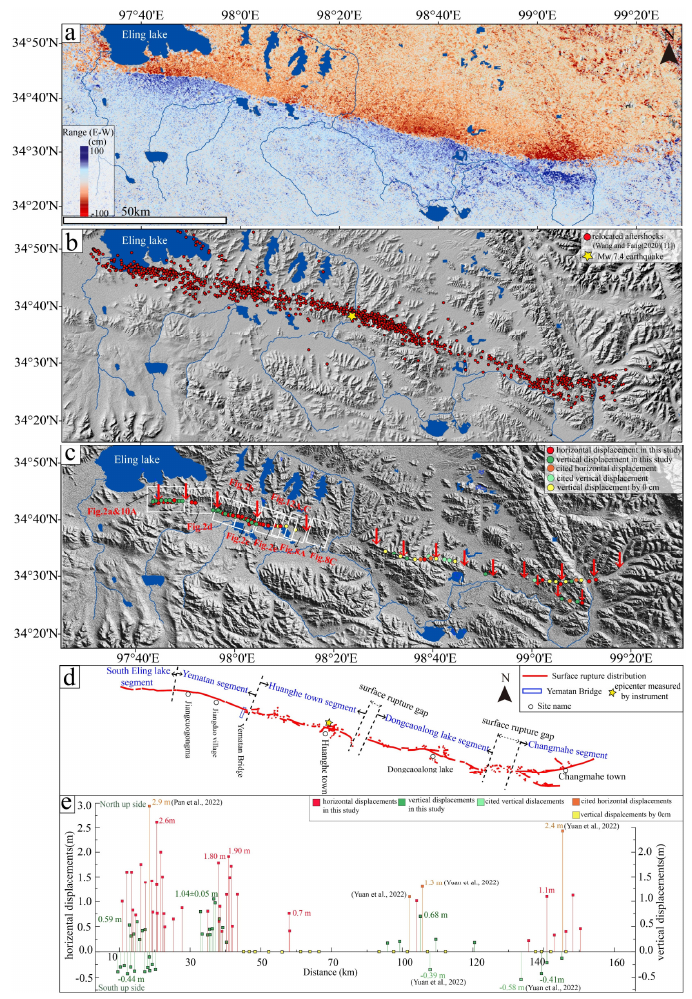
Figure 3. ( a ) LiCSAR observations of the Maduo earthquake (Adapted with permission from Dr. Sotirios Valkanioti); ( b ) Relocated aftershocks adapted from Wang et al. (2022) [11]; ( c ) co-seismic surface rupture distribution and the displacement point sites; ( d ) co-seismic surface rupture segmentation; ( e ) displacements’ distribution, the cited displacements from Yuan et al. (2022) [35] and Pan et al. (2022) [36].